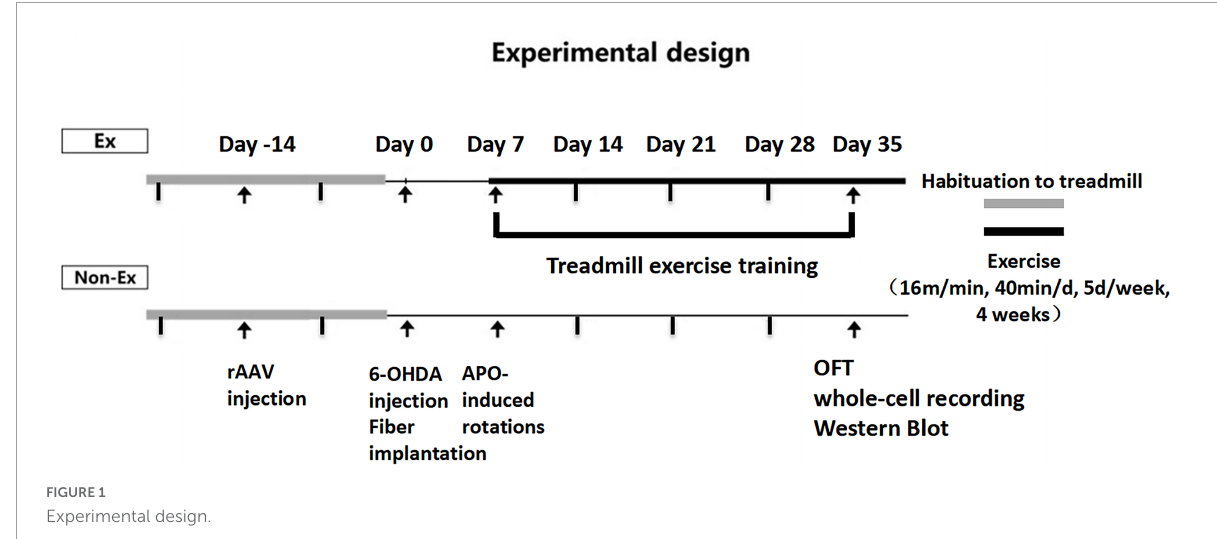
FIGURE1 Experimental